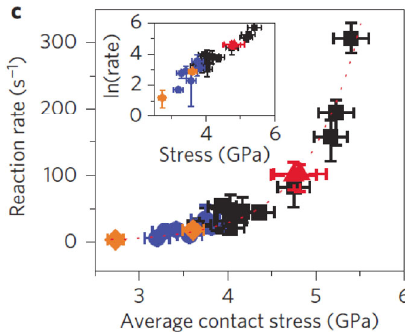
Fig. 17 Influence of contact pressure on the wear rate of pure silicon against diamond in a TEM. Reproduced with permission from [139]. Copyright Nature, 2013.